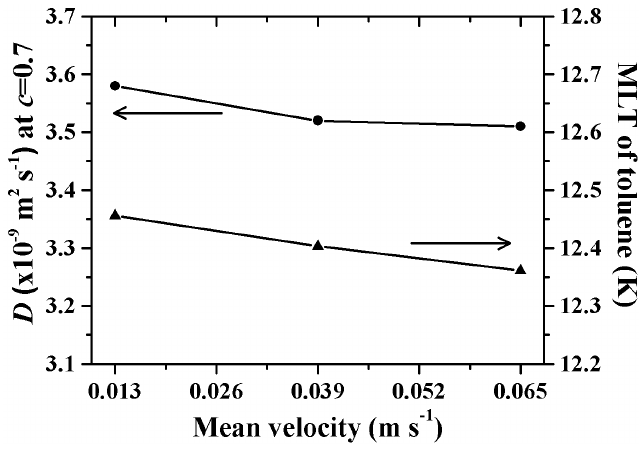
Figure 8. Comparison of simulation and experimental results, in terms of the influence of the surface power on the heating effect. d =1 μ m and U =0.013 m·s − 1 .